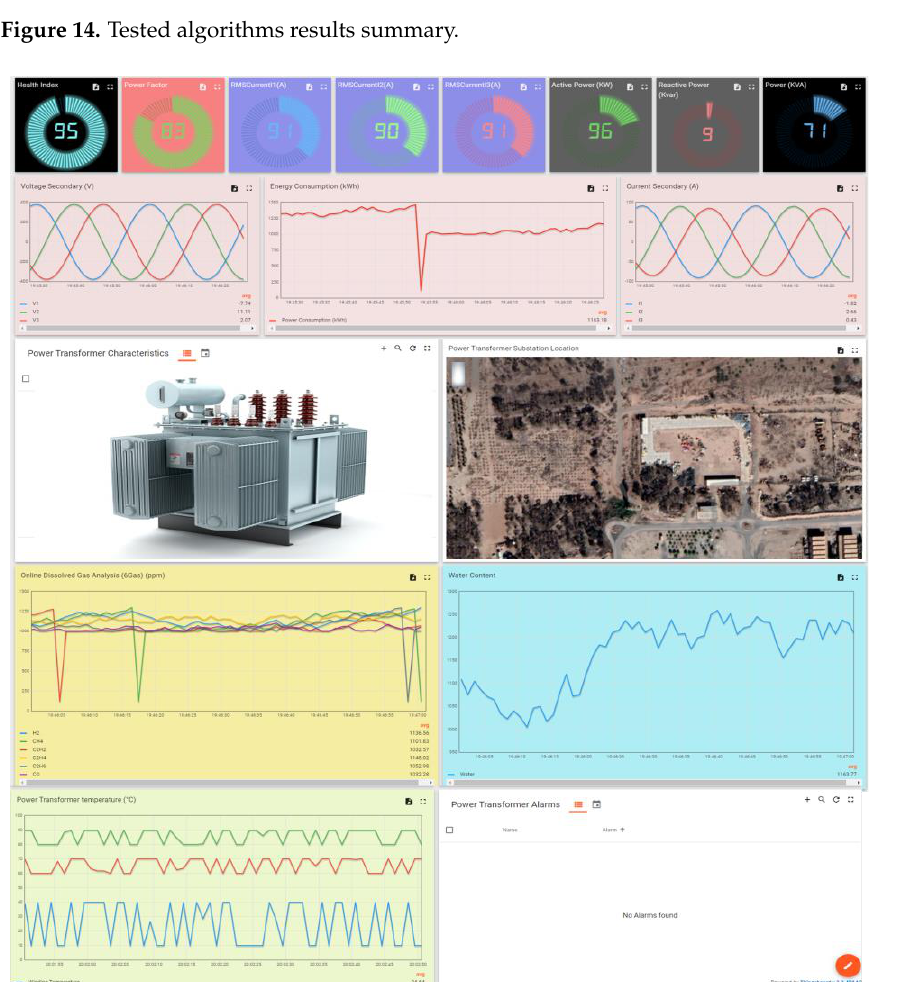
Figure 15. Online monitoring interface